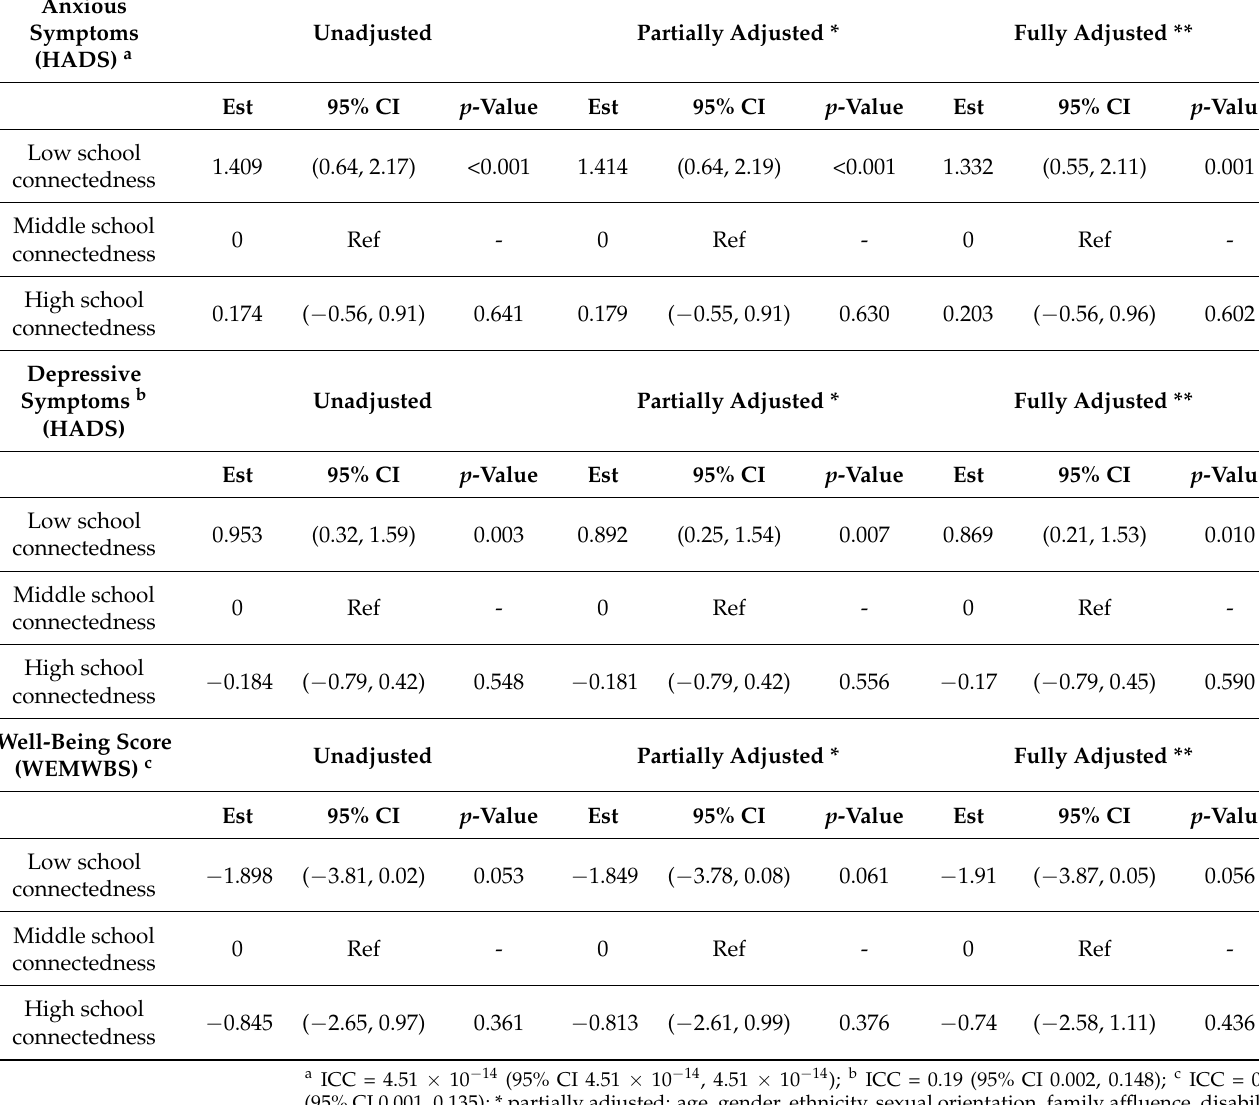
Table 3. Association of school connectedness with change in adolescent anxious and depressive symptoms and well-being scores between lockdown and return to